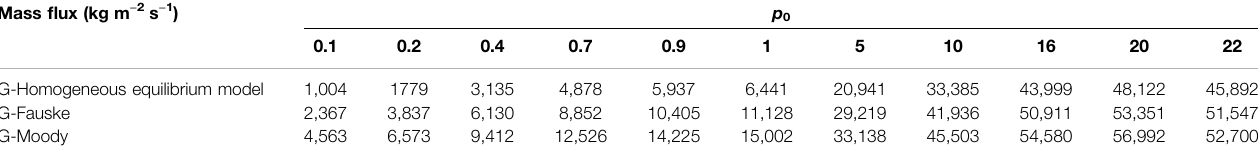
TABLE 1 | Comparison of critical mass fl ux with homogeneous equilibrium model, Fauske model and Moody